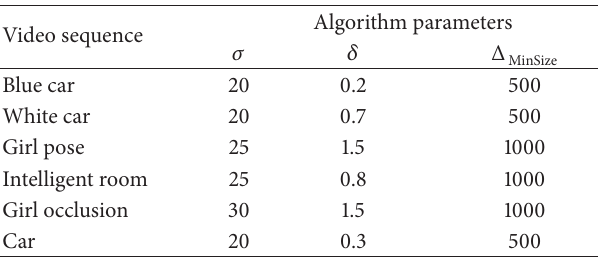
Table 2: Algorithm parameters.